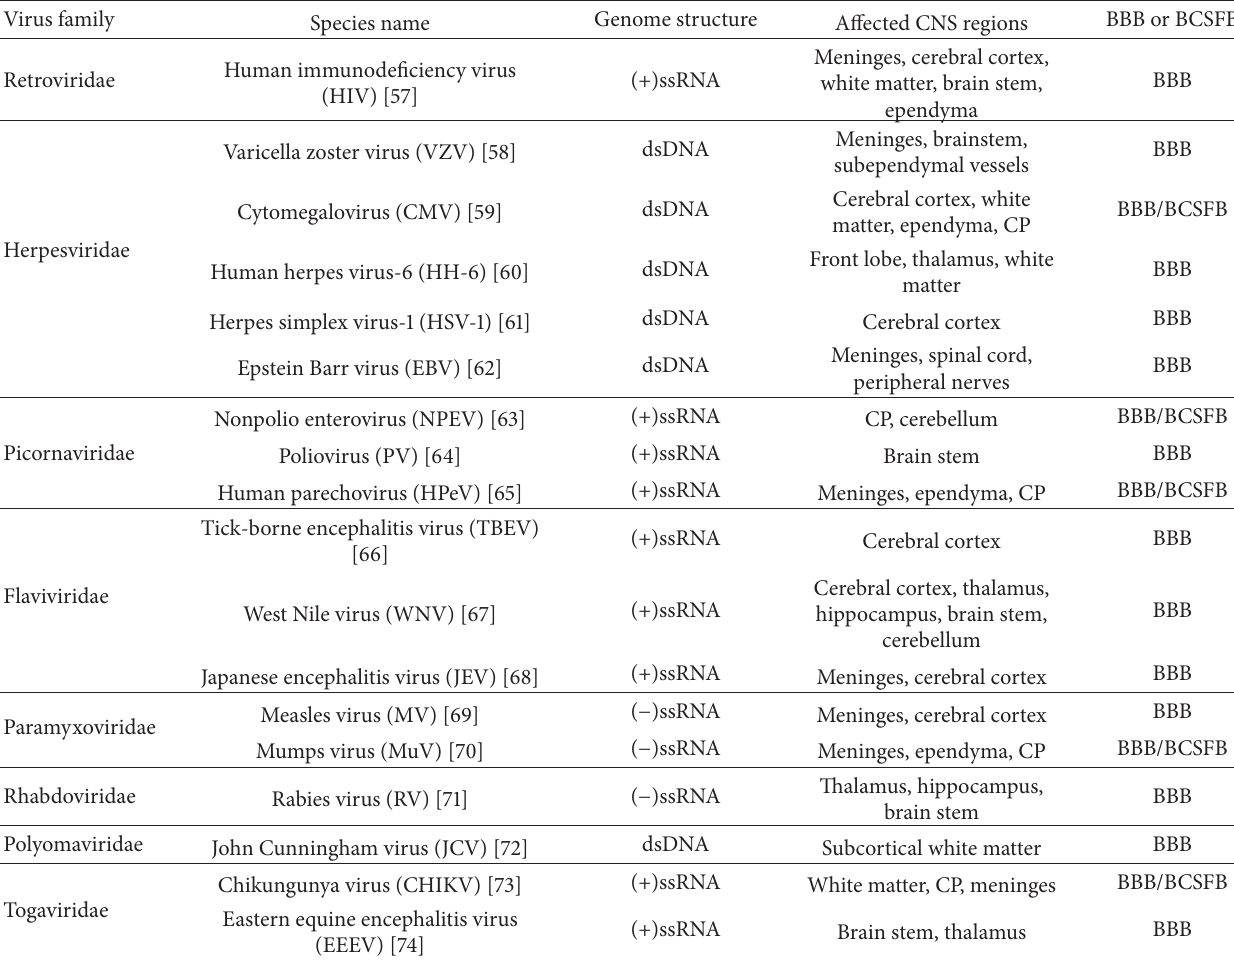
Table 1: Classification, characterization, and affected CNS regions of relevant viruses causing infection in the human CNS. Virus